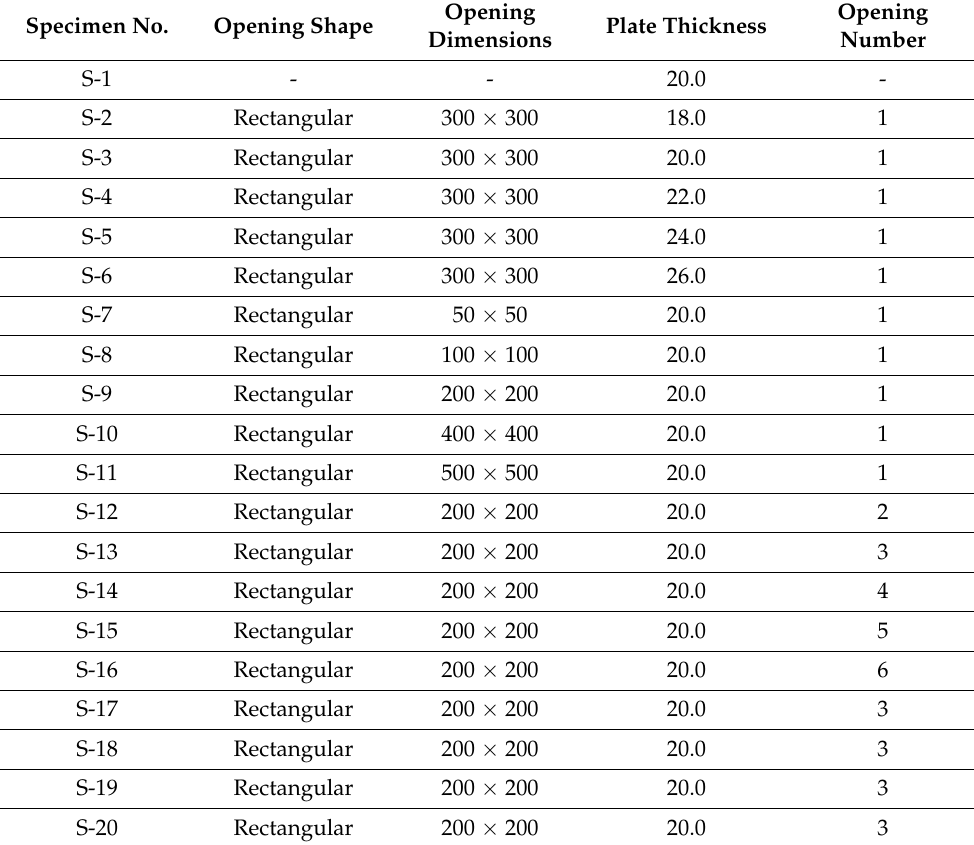
Table 1. Detailed parameters of the modelled specimens. Specimen